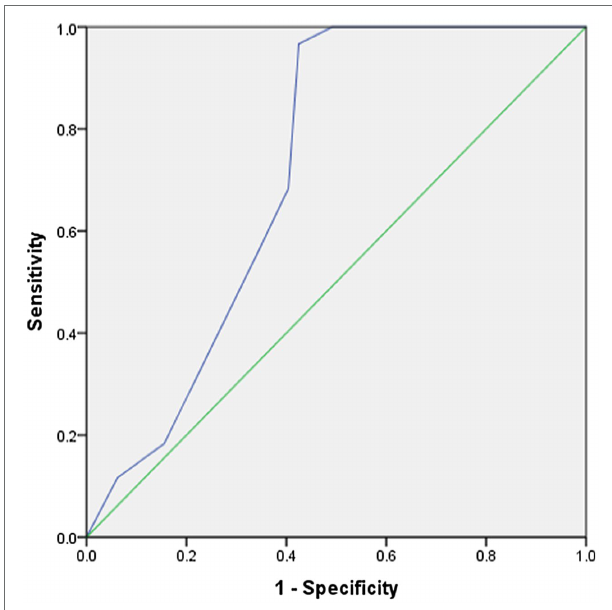
FIGURE 4 | ROC curve (teaching